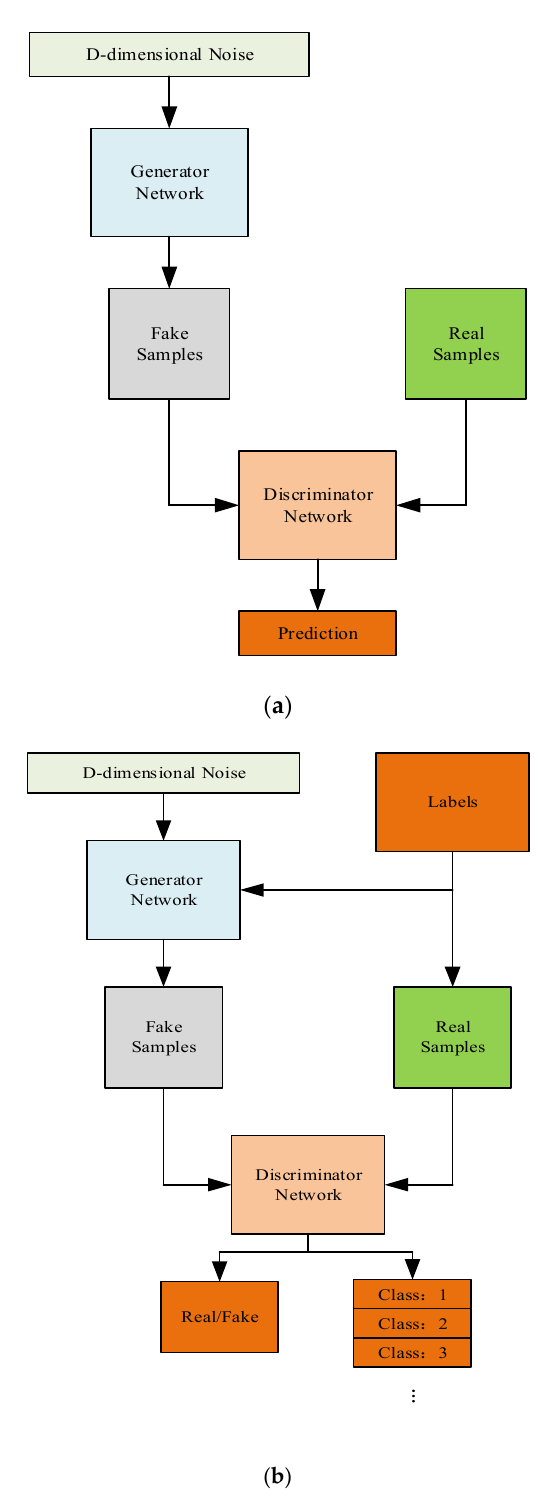
Figure 1. Structures of GAN and ACGAN. ( a ) Structure of original GAN; ( b ) structure of original ACGAN.